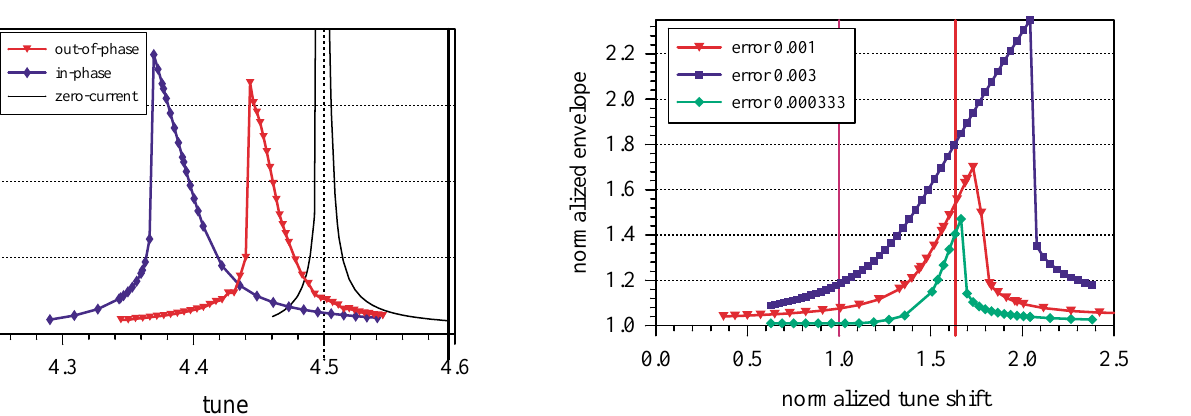
FIG. 2. (Color) Maximum envelope excursions (normalized to initial value) for symmetric and antisymmetric focusing errors at variable intensity with fixed bare tune n 0, x , y (cid:1) 4.6 , and for zero space charge case varying n 0, x , y ( 10 2 3 level error at harmonic n (cid:1) 9 ).